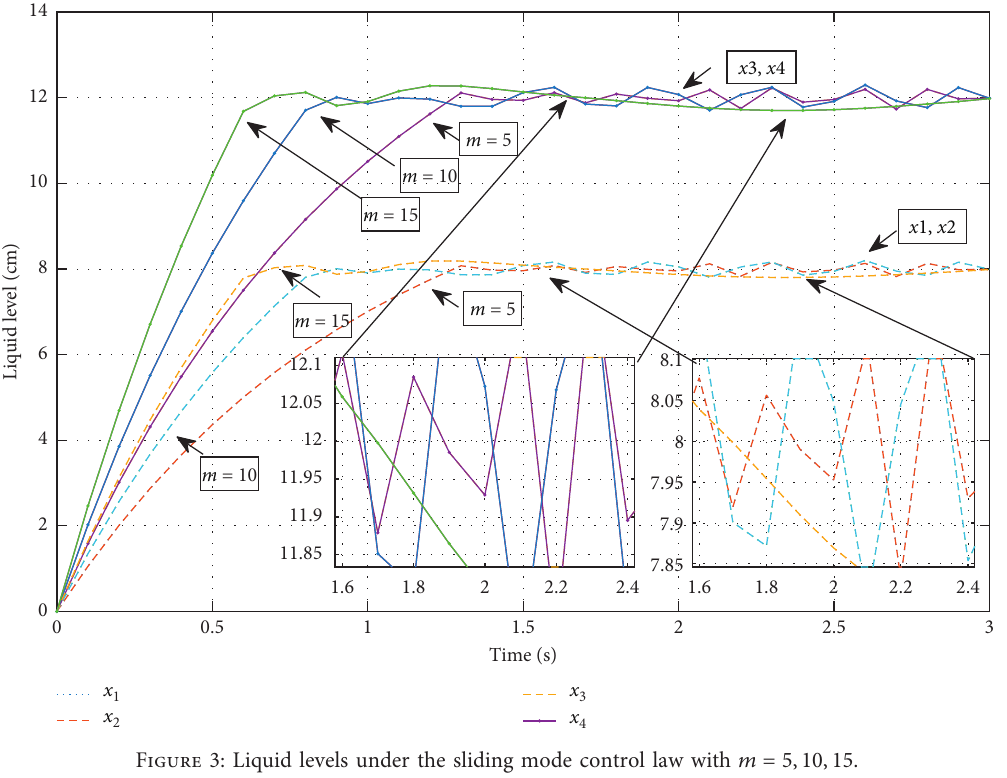
Figure 3: Liquid levels under the sliding mode control law with m � 5 , 10 ,